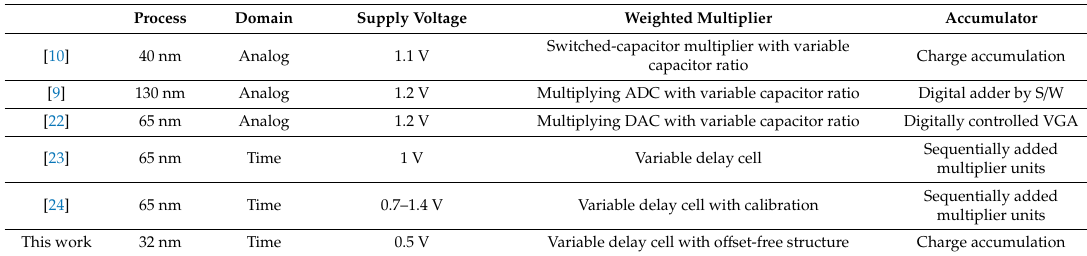
Table 2. Architecture